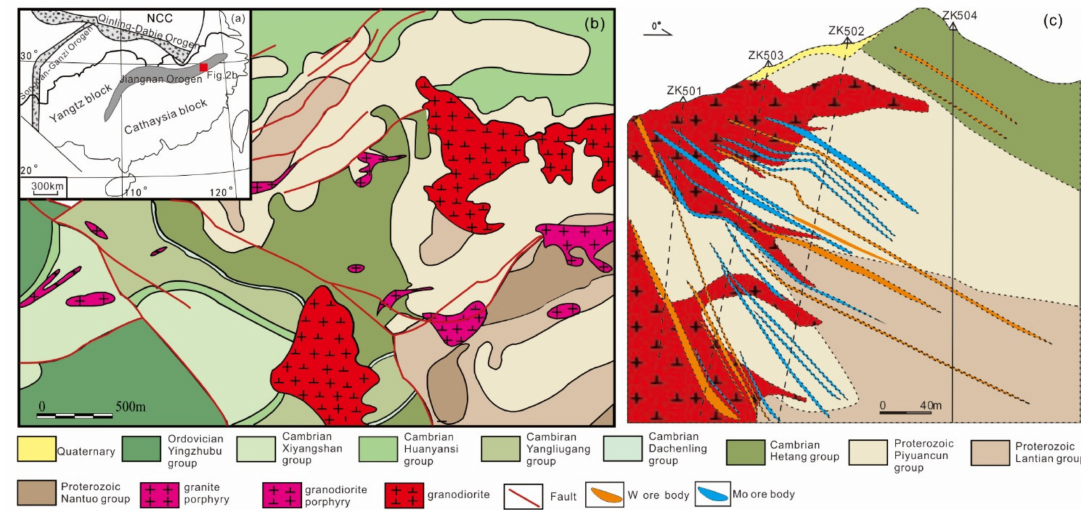
Figure 2. ( a ) Tectonic location of the Jiangnan orogeny; ( b ) geological map of Zhuxiling W(Mo) deposit; ( c ) geological cross section map of the Zhuxiling W (Mo) deposit, illustrating sampling drill hole (after [24]).